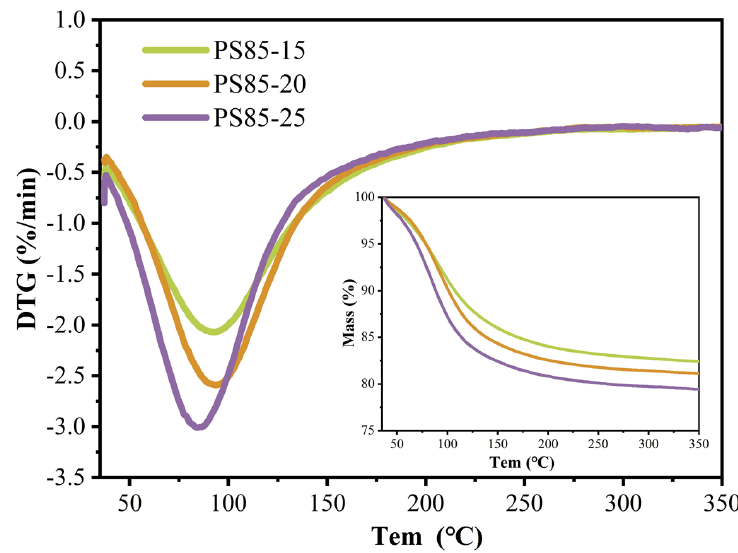
Figure 7. TG-DTG curves of WUFA-PS-based geopolymers with different activator contents at 28 days.